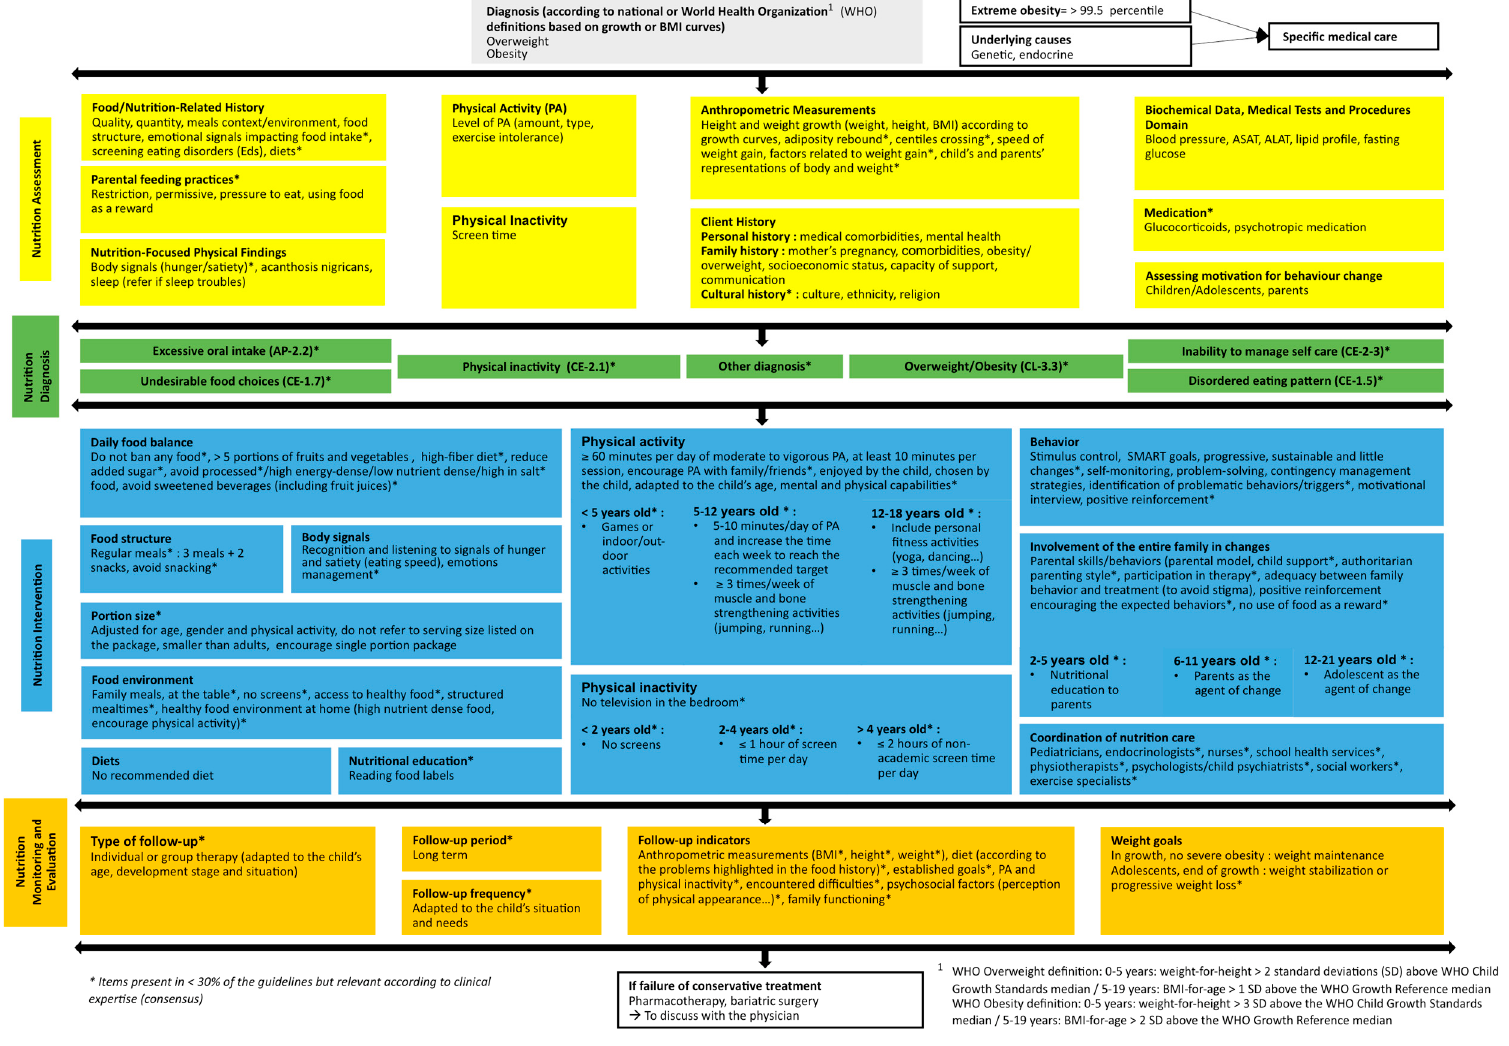
Figure 1. Structured framework on the nutritional management of overweight and obesity in children and adolescents.